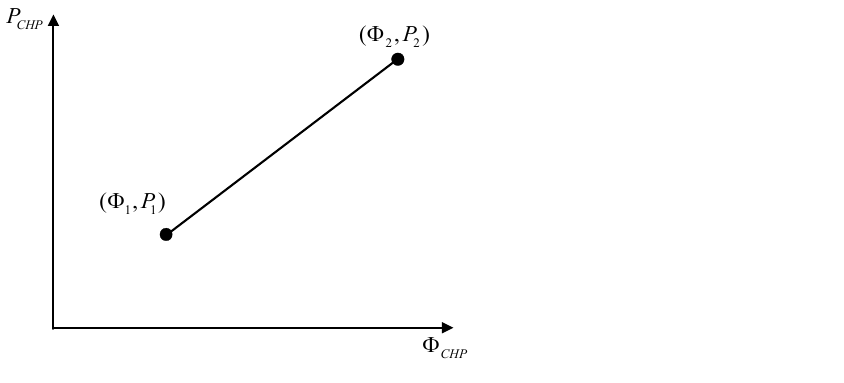
Figure 4. Electrothermal characteristic diagram of the back-pressure unit.